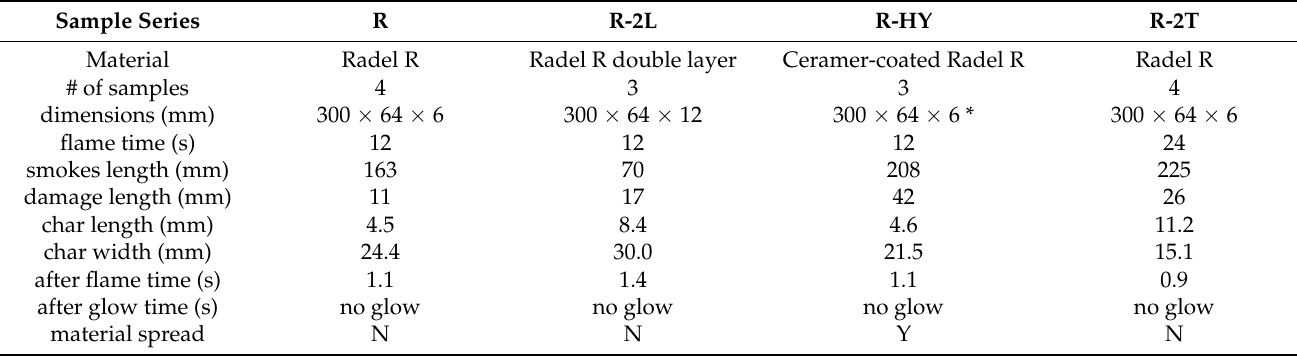
Table 1. Flammability test: main characteristics of samples classes and experimental setup (upper box), and experimental results (lower